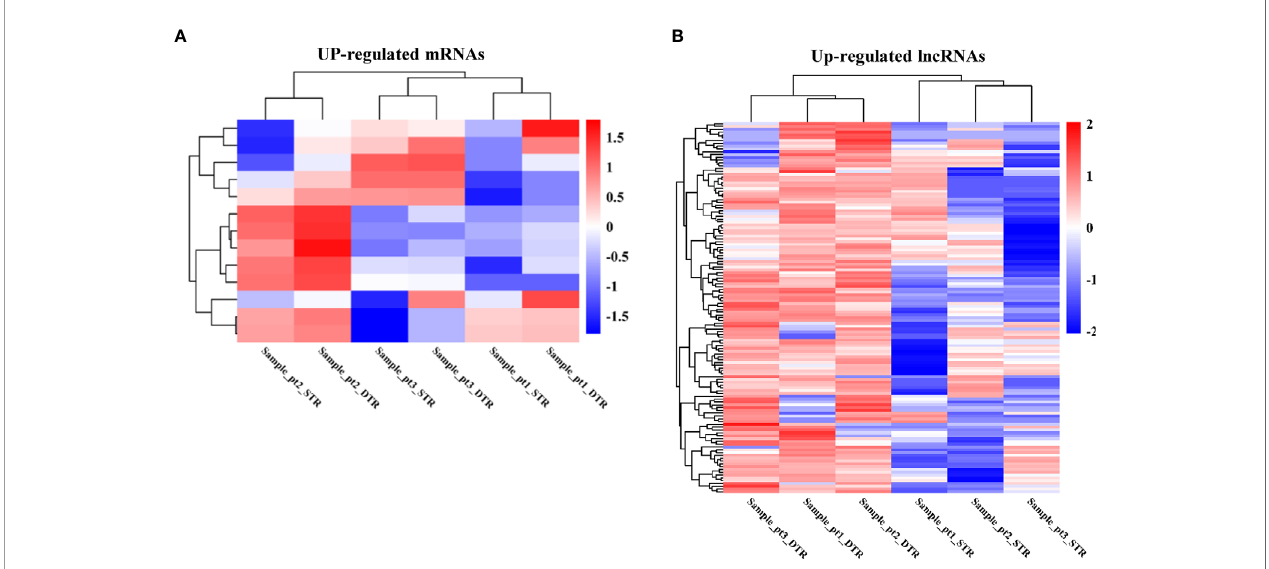
FIGURE 2 | The heatmap of signi fi cantly upregulated mRNAs (A) and lncRNAs (B) in deep in fi ltrating tumor regions (DTR) compared with the super fi cial tumor regions (STR) of